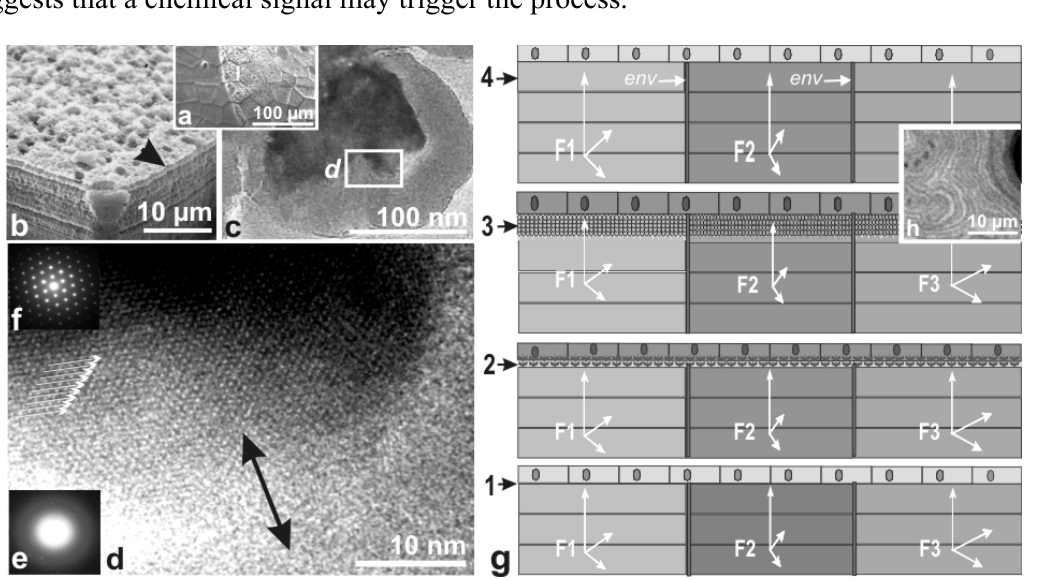
Figure 7. Illustration of a transition from amorphous to crystallized status at the growth front of the reticulate biocrystal ( a – f ) and scheme of the depositional and crystallization cycle forming a growth layer ( g ). 7 a – e : Internal surface of the calcite prisms at the forefront of a growing edge of a calcite prism ( Pinna ), showing the partly stripped gel layer ( a ) and the underlying surface of the growing prism ( b ); TEM observation of the grains ( c , d ) provides a view of what can be the transition between amorphous status of the gel-layer and crystallization of the Ca-carbonate (double-headed arrow). TEM diffraction patterns clearly oppose amorphous ( e ) and crystallized areas ( f ). Arrow heads underline the well ordered arrangement of crystallized area; 7g: Schematic view of the depositional sequence of a growth layer. When the cycle is starting the mineralizing epithelium is in contact with the last formed growth layer ( g 1). The mineralization process does not involve any liquid space: separation of the cell layer from the mineralized structure results from secretion process, producing an organic-hydrogel layer, with thickness in the micrometer range ( g 2– g 3). 7h: Synchronized crystallization process within the gel-layer may occur when the relevant thickness is reached (with local modulation): Mg banding pattern mapped from coral fibers suggests that a chemical signal may trigger the